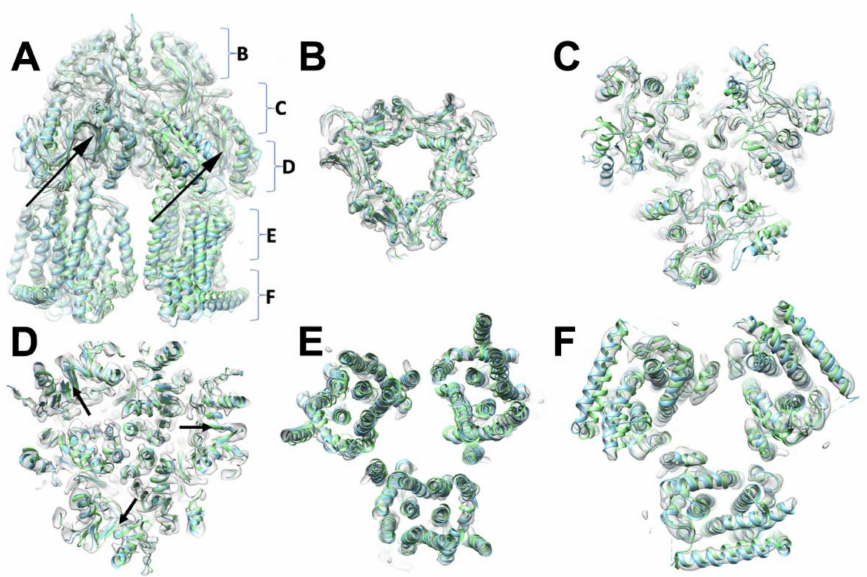
Figure 2. Comparison of E. coli and S. Typhimurium AcrB three-dimensional (3D) structures. ( A ). A side-view of the trimer of the S TmAcrB G288D refined model (cyan) superposed over the E. coli orthologue( Ec AcrB)(lightgreen)andfittedintotheexperimentalelectrondensitymap(semi-transparent grey). ( B – F ) Horizontal slices through the S TmAcrB C3 cryo-EM electron-density map from the top ( B ) to base ( F ). Both S TmAcrB G288D and Ec AcrB are fitted within the density. The relative positions of the slices are indicated in ( A ). The position of G288D mutation within the structure is indicated with black arrows in ( A ) and ( D ).